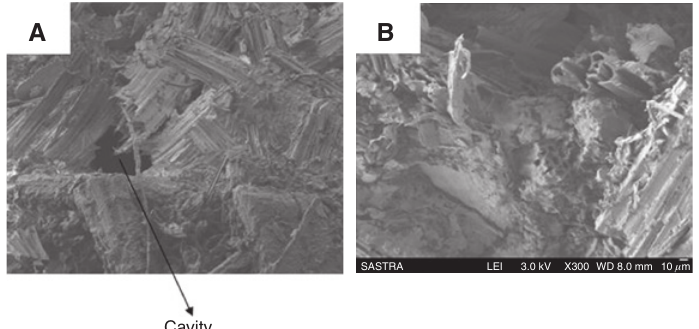
Figure 10 SEM images of tensile fracture surface of (A) untreated and (B) chemically treated MSW/banana fiber composites (ratio of MSW/ banana fiber =